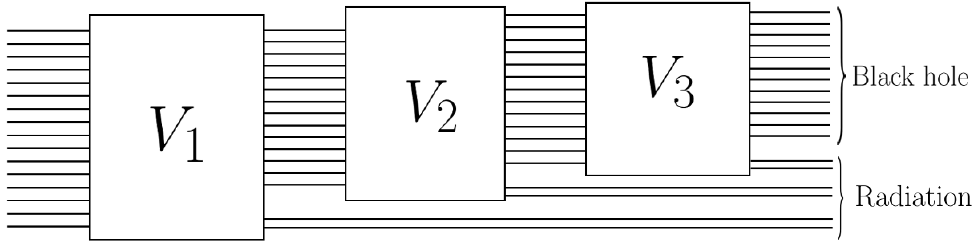
Figure 3 . A simple two model of an evaporating black hole that incorporates thermodynamic irreversibility. At each time step, two qubits are released from the black hole as Hawking radiation and then a random isometry is applied to the black hole that adds a single qubit. This model is an example of a random tensor network and hence obeys a version of the Ryu-Takayanagi